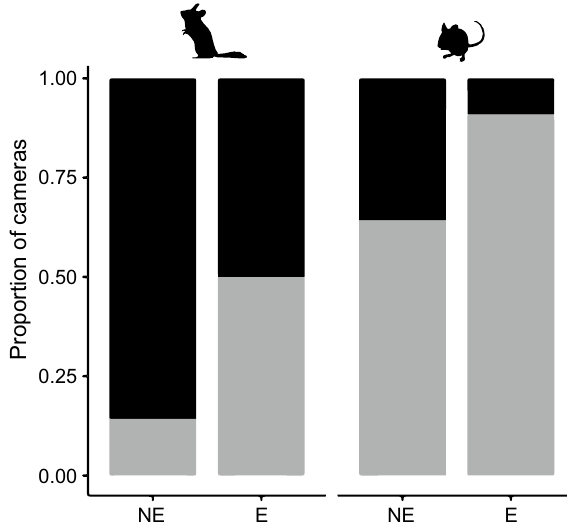
Figure 6. Proportion of camera-traps with presence of common genet inside lynx territories which in occurred an encounter with an Iberian lynx (E) or not (NE). Black colour shows the proportion of cameras with absence of micromammals and grey colour shows presence of micromammals. The first silhouette refers to the garden dormouse ( E. quercinus ) and the second silhouette to other rodents ( A. sylvaticus, M. spretus and R. rattus ).